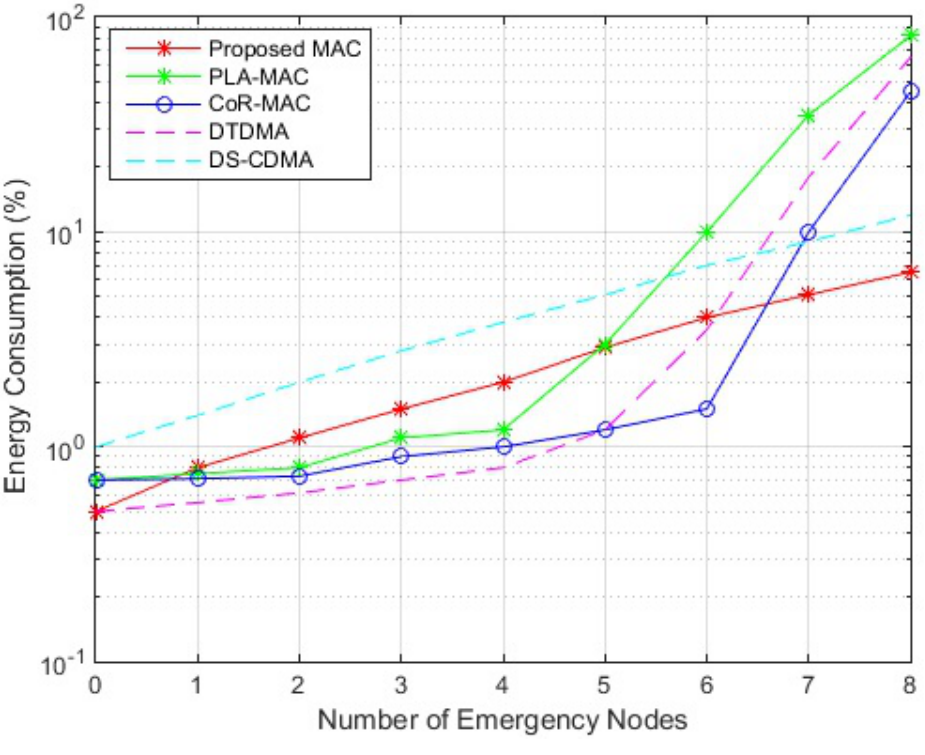
Figure 6. Energy Performance of MAC